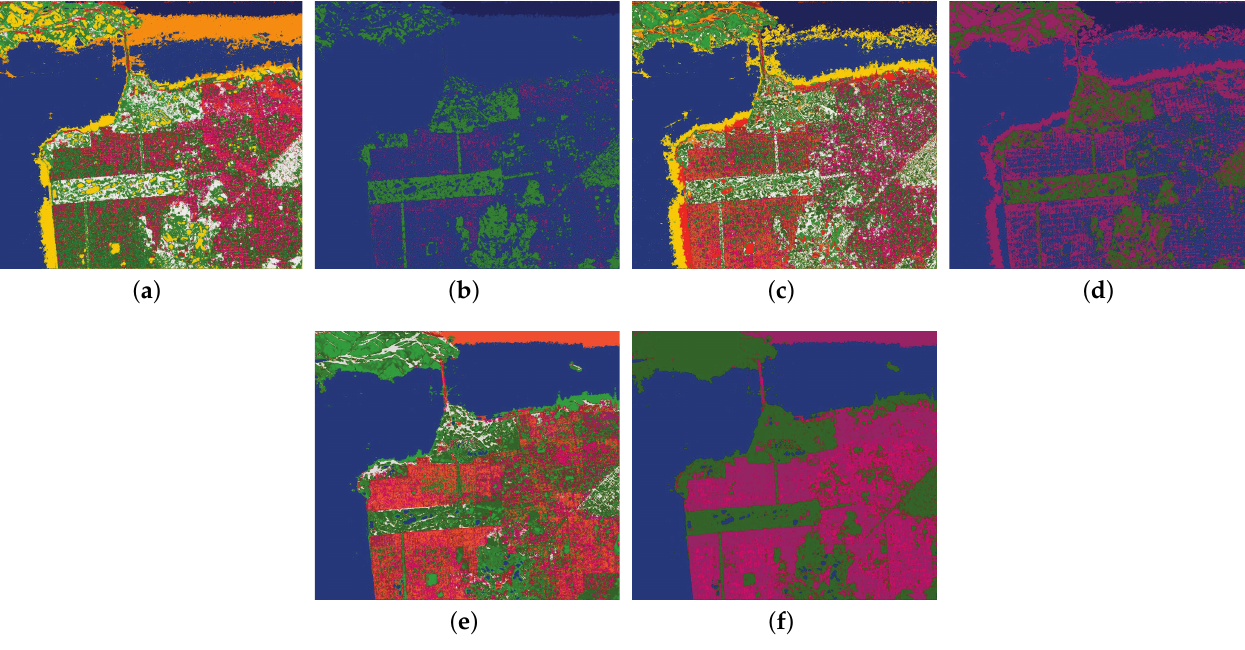
Figure 12. Classification results of different algorithms and class numbers. ( a ) Result of H / A / α - Wishart with 16 classes. ( b ) Result of H / A / α -Wishart with 5 classes. ( c ) Result of h / q / gray -Wishart with 16 classes. ( d ) Result of h / q / gray -Wishart with 5 classes. ( e ) Result of the proposed with 16 classes. ( f ) Result of the proposed with 5